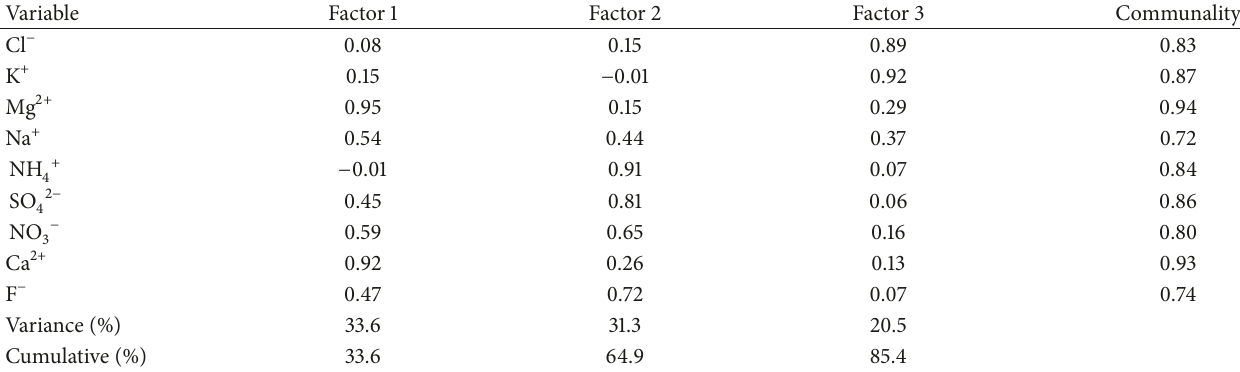
Table 3: Varimax-rotated principal factor analysis of ions in the precipitation of Wanzhou.